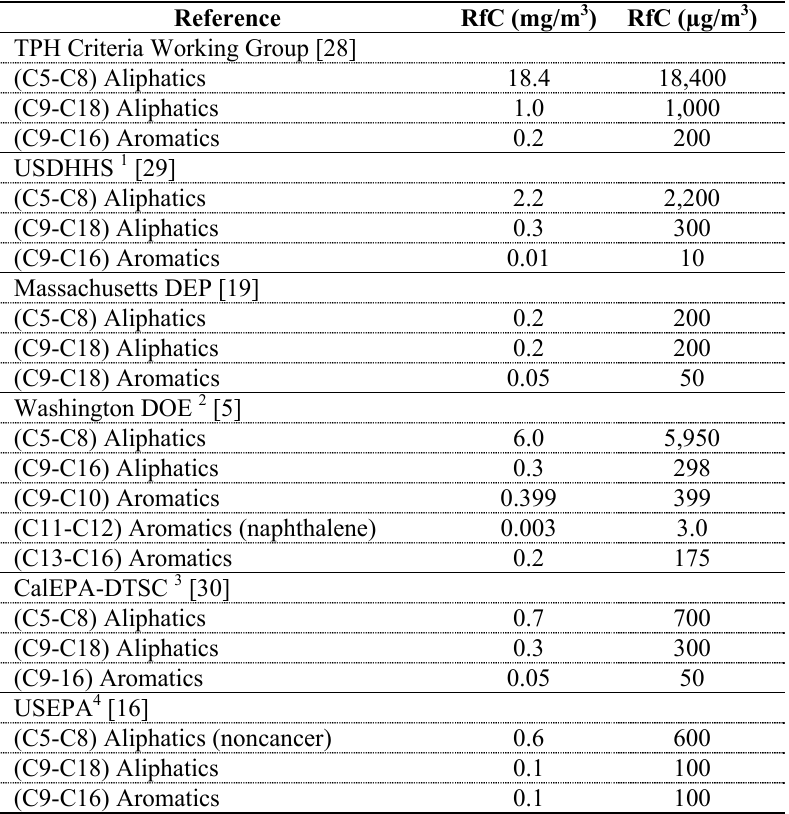
Table 4. Published inhalation toxicity factors for petroleum aliphatic and aromatic carbon ranges (listed in order of